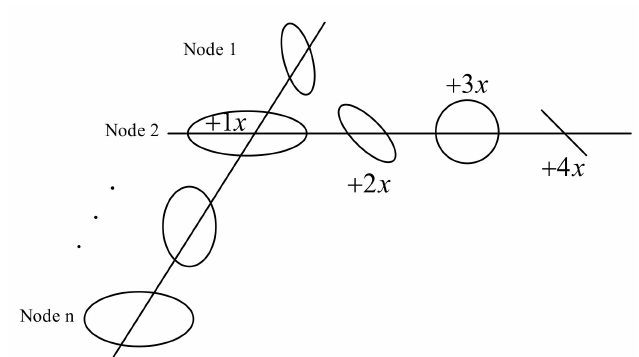
Figure 11. The 3D